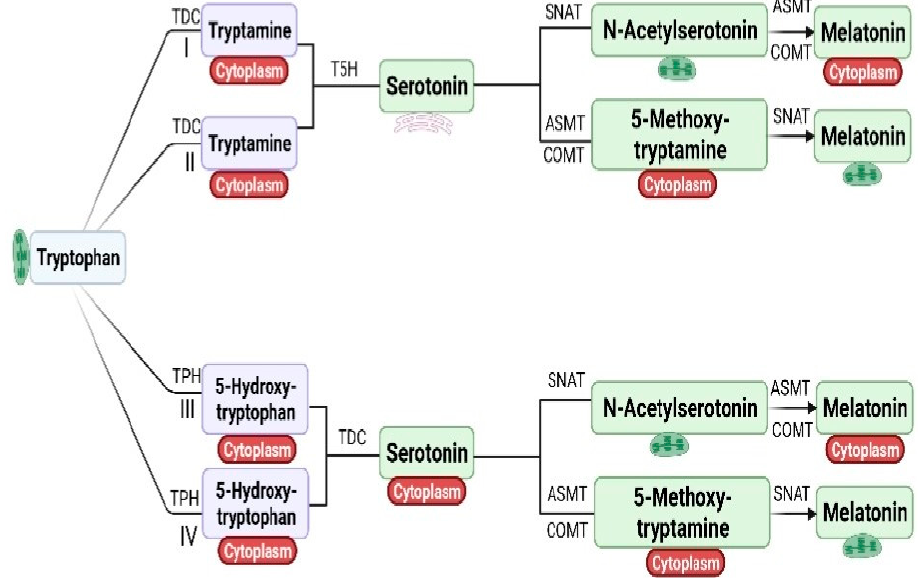
Figure 1. Biosynthesis of melatonin in plants. Abbreviations: TDC, tryptophan decarboxylase; TPH, tryptophan hydroxylase; T5H, tryptophan 5-hydroxylase; SNAT, serotonin N -acetyltransferase; ASMT, N -acetylserotonin methyltransferase; COMT. Caffeic acid O-methyltransferase